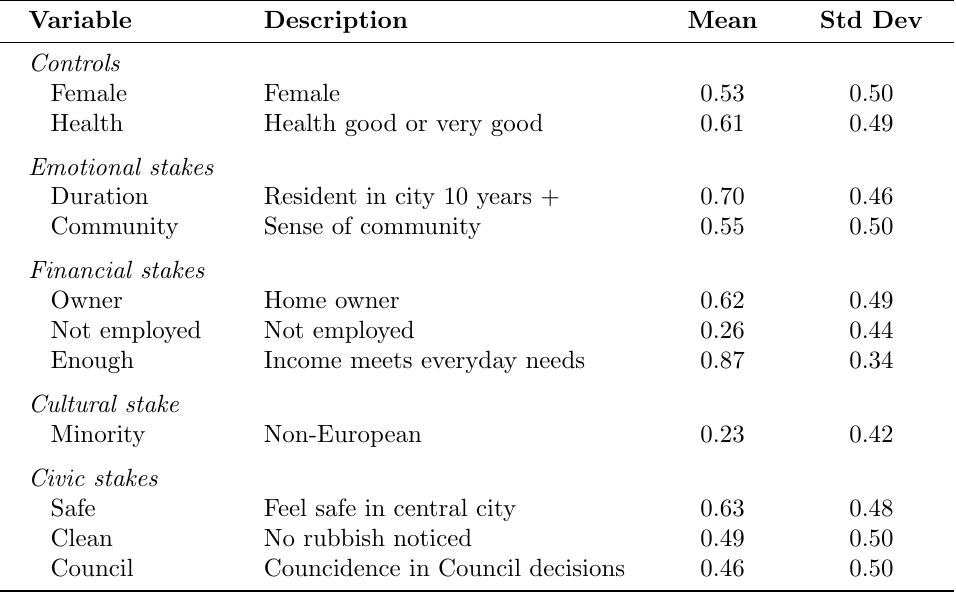
Table 3: Measures of stake holding and controls used in the modelling of urban pride. New Zealand,